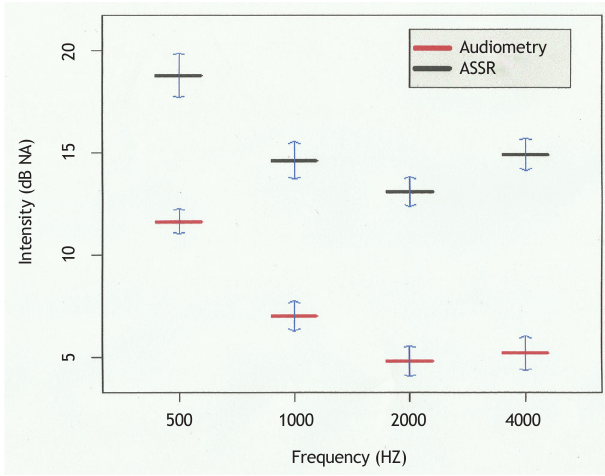
Figure 1 Mean thresholds on PT and ASSR and respective standard errors. The figure shows the mean thresholds obtained in tonal audiometry and auditory steady-state responses (ASSR) at fre- quencies of 500, 1,000, 2,000, and 4,000 Hz with their respective standard error (n = 52